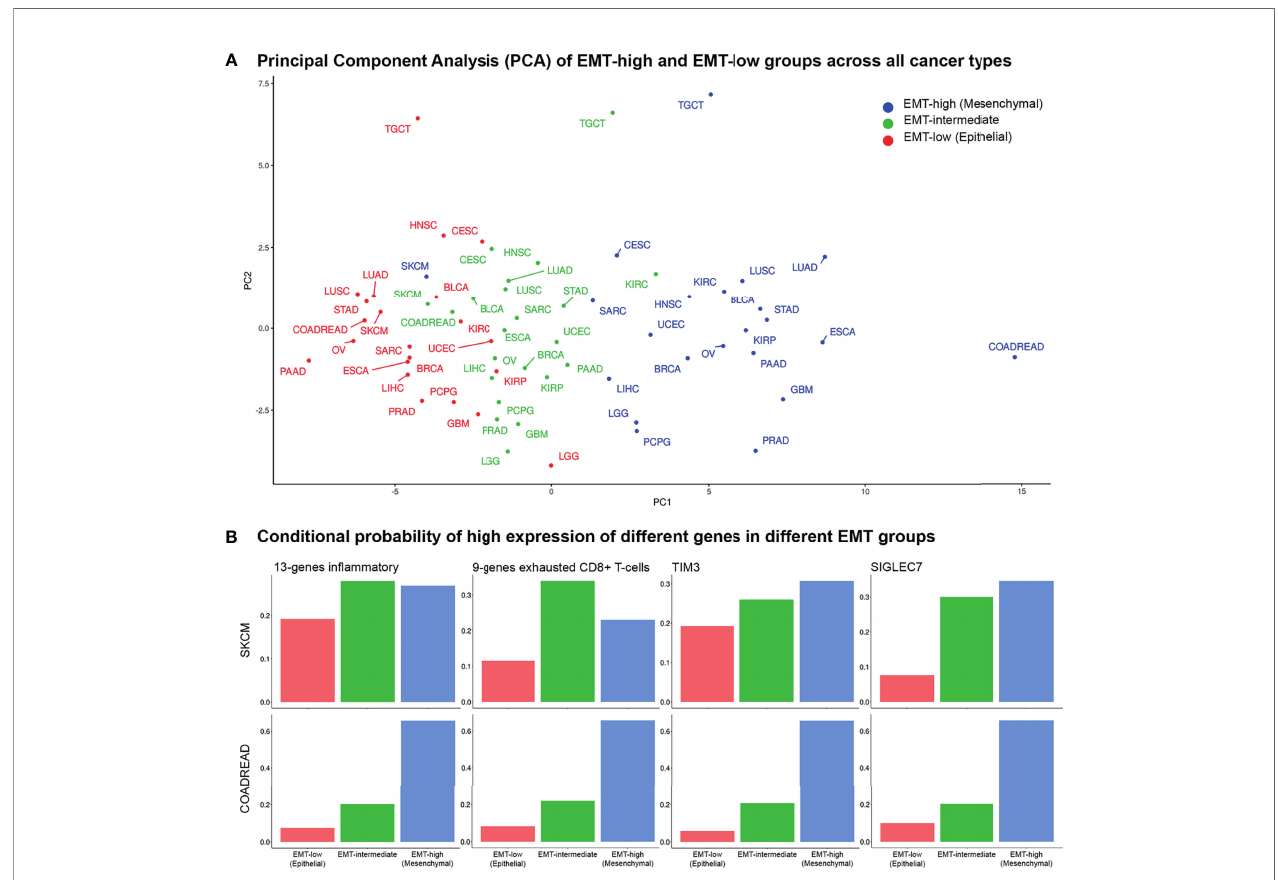
FIGURE 7 | Principal component and conditional probability analysis: (A) Principal component analysis (PCA) of tumor immune microenvironment (TIME) markers across all cancer types in all three epithelial – mesenchymal transition (EMT) groups. Skin Cutaneous Melanoma (SKCM) patients belonging to the three EMT groups cluster together, whereas for COADREAD, they are far apart. (B) Conditional probabilities of high expression of top 4 TIME markers in PCA given it belongs to a given EMT